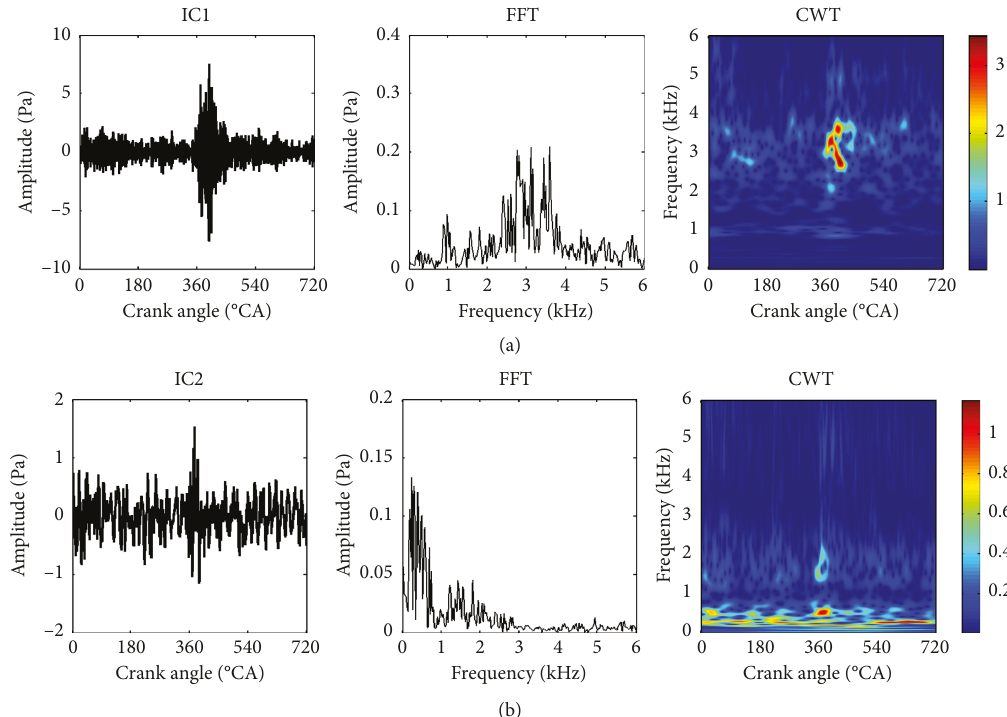
Figure 14: Time-domain waveform, spectrum, and time-frequency diagram of (a) IC1 and (b) IC2 from cylinder head top noise signal y 1.